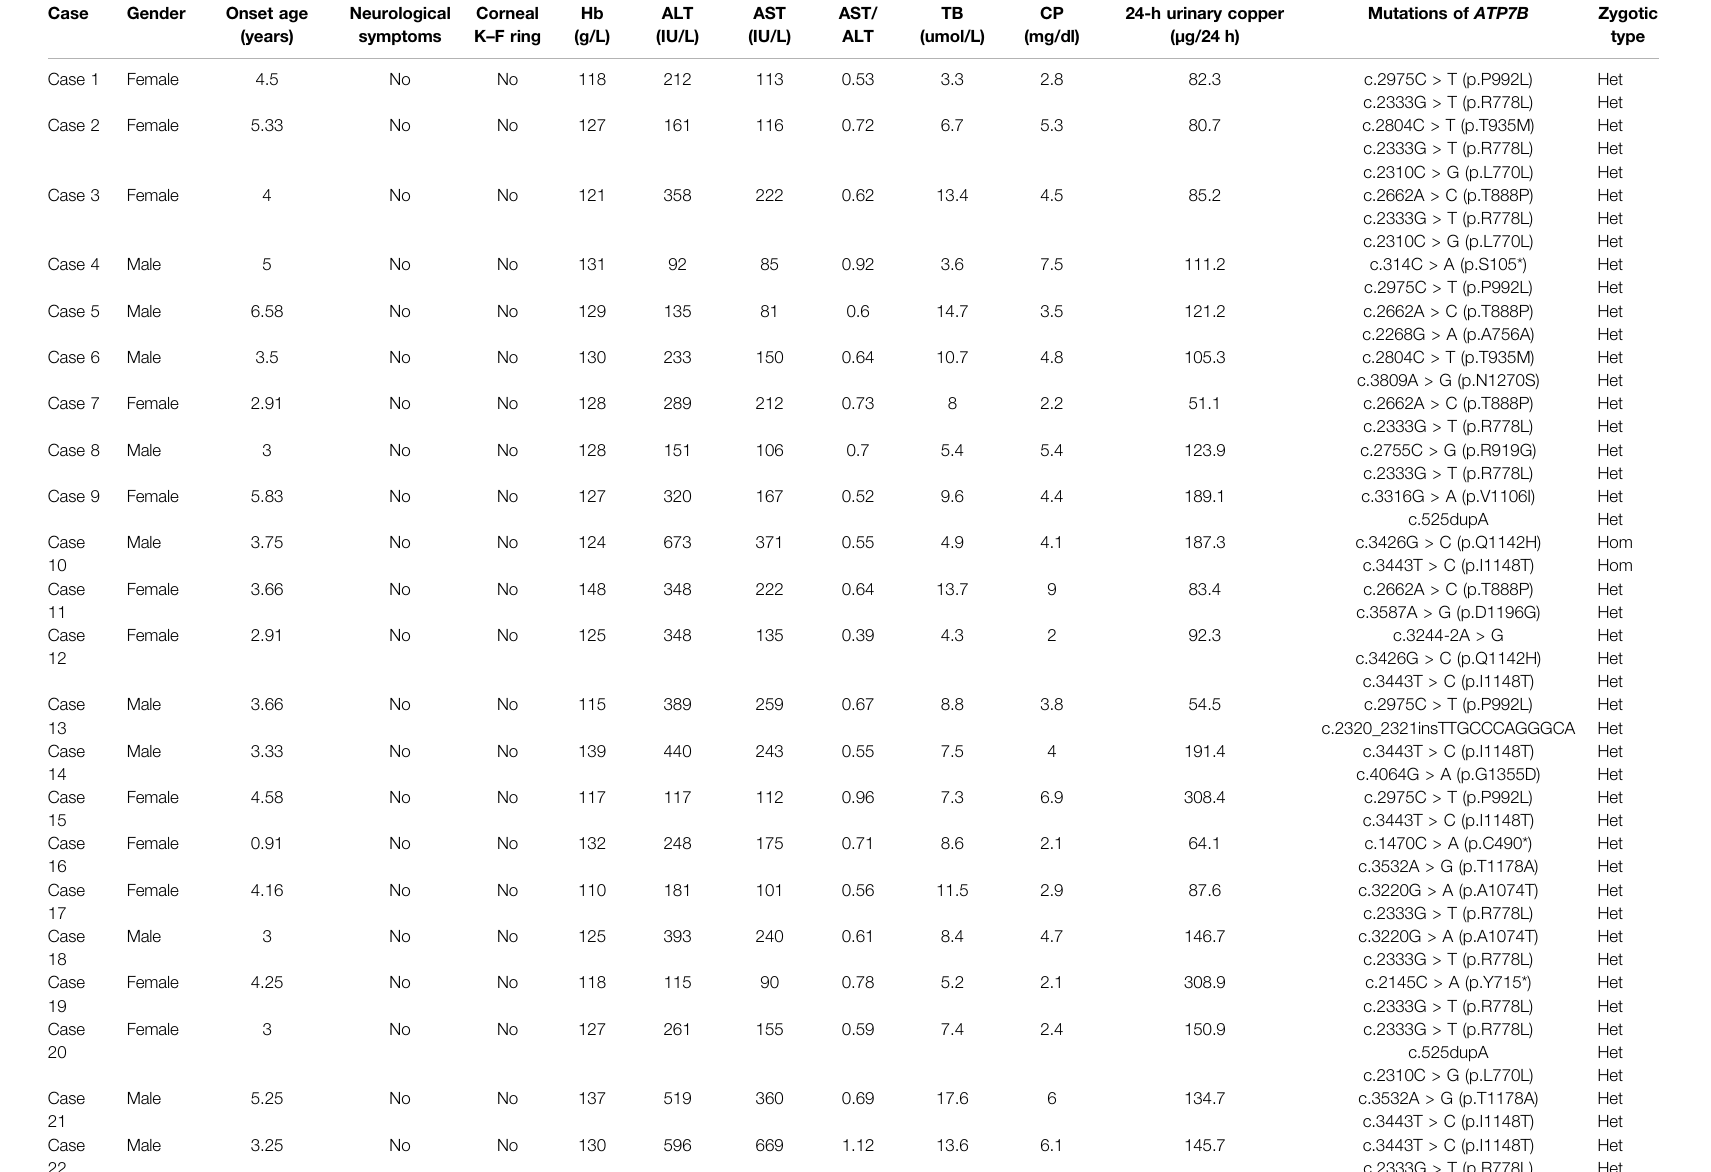
TABLE 1 | Detailed clinical information of 30 children with